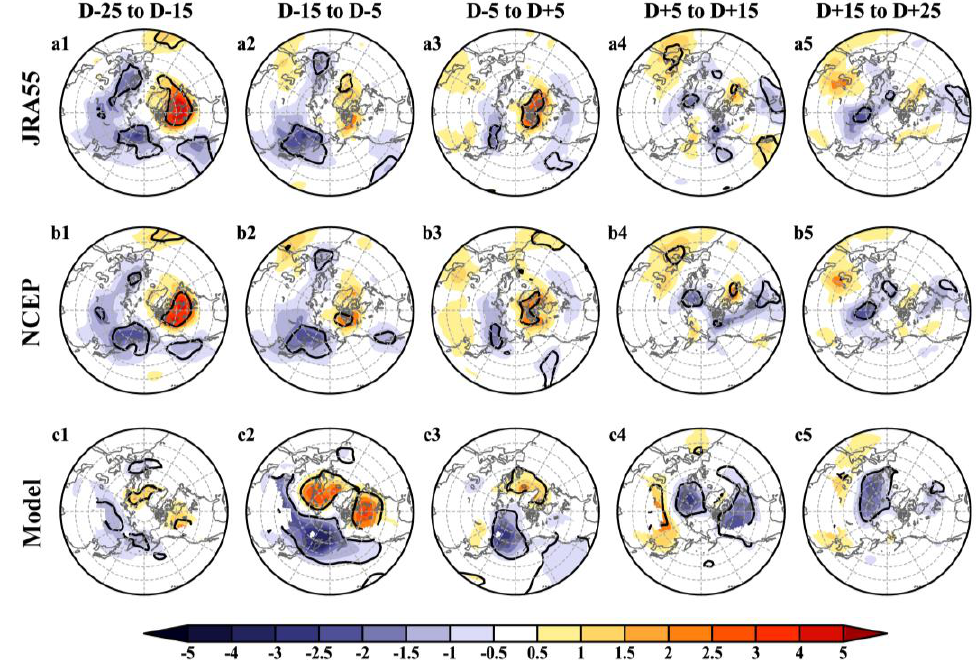
Figure 10. Same as in Figure 7, but for temperature anomaly distribution (shading, units: K) at 850 h Pa.